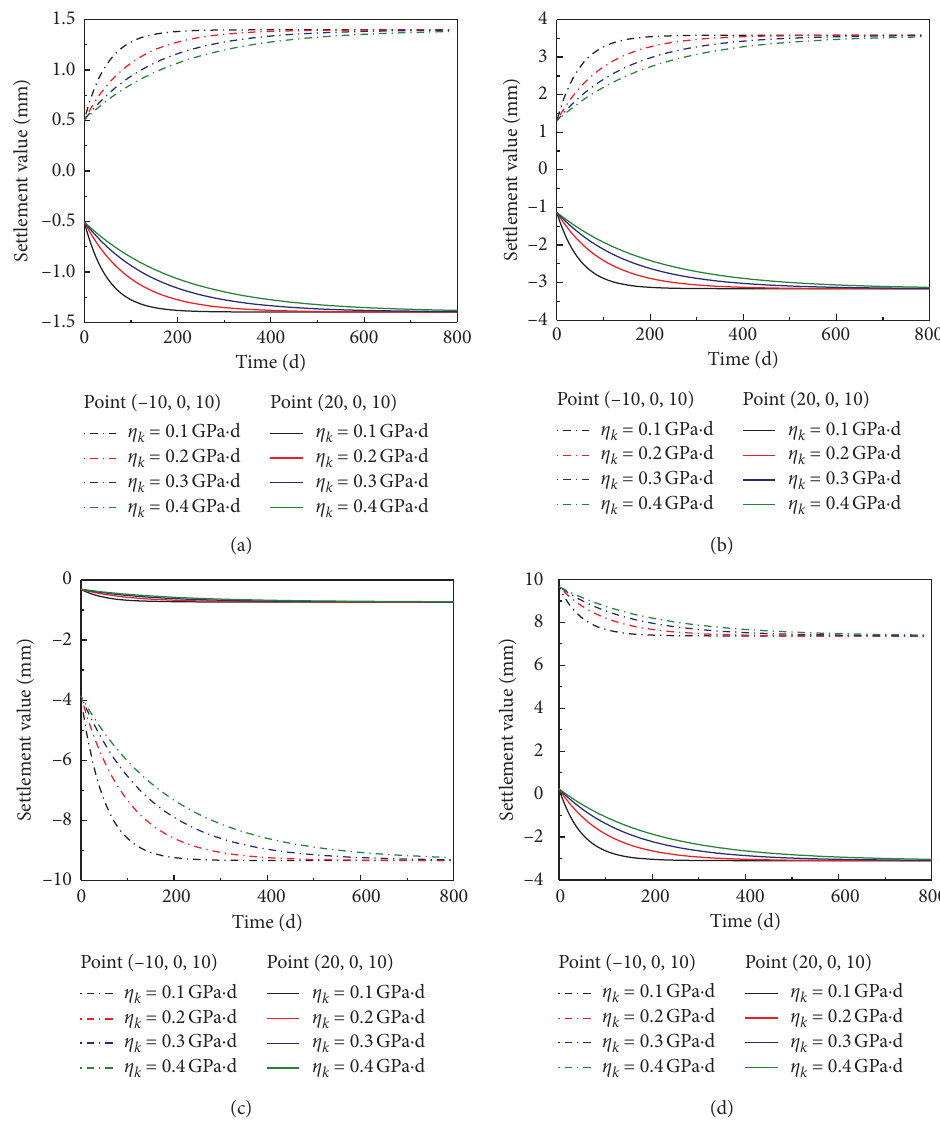
Figure 5: Different viscosity coefficients, η k , cause a change in the settlement value at point (20, 0, 10) and point (–10, 0, 10) with time under the action of the support pressures (a), shield shell frictions (b), grouting pressures (c), and total displacement over time (d).